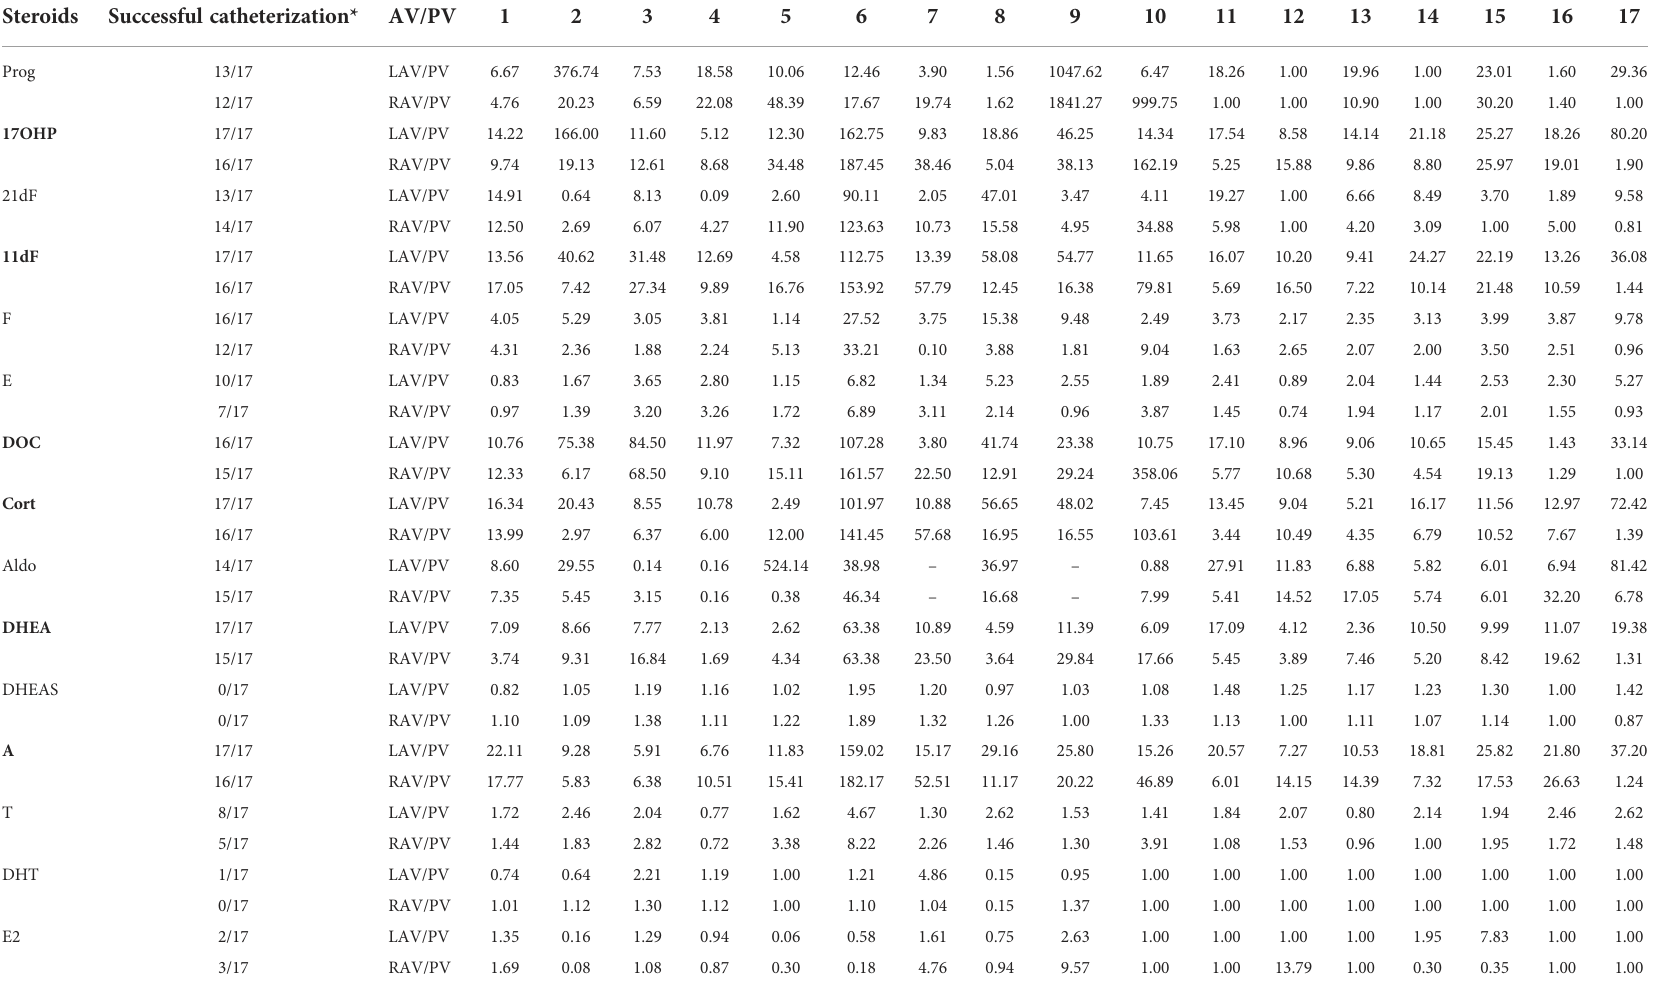
TABLE 2 Concentration gradient (selectivity index, SI) of each steroid from adrenal vein (AV) to peripheral vein (PV) in 17 patients. Steroids Successful catheterization*